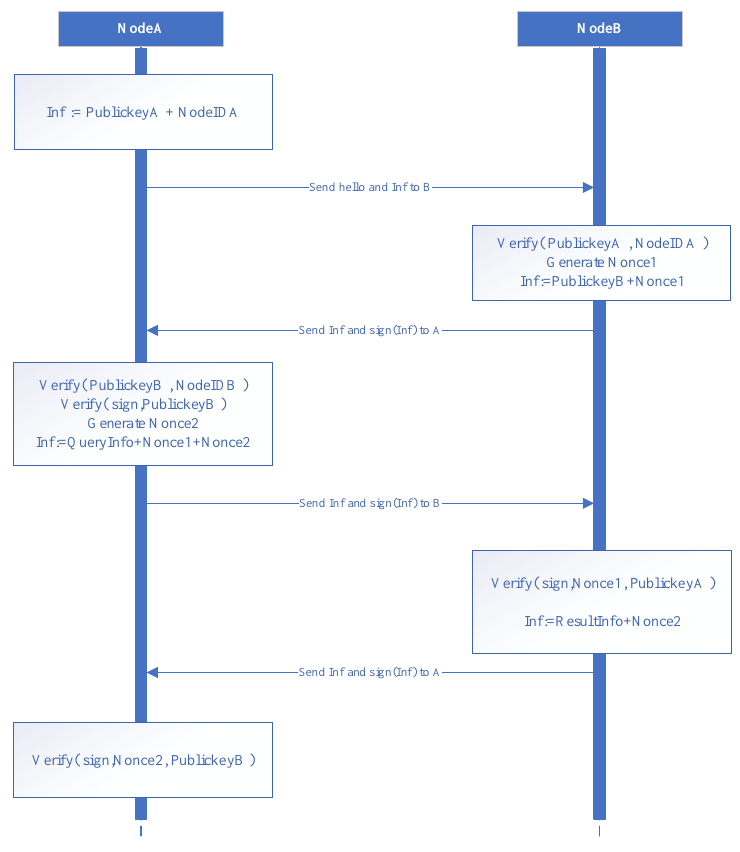
Figure 7. The workflow of public message